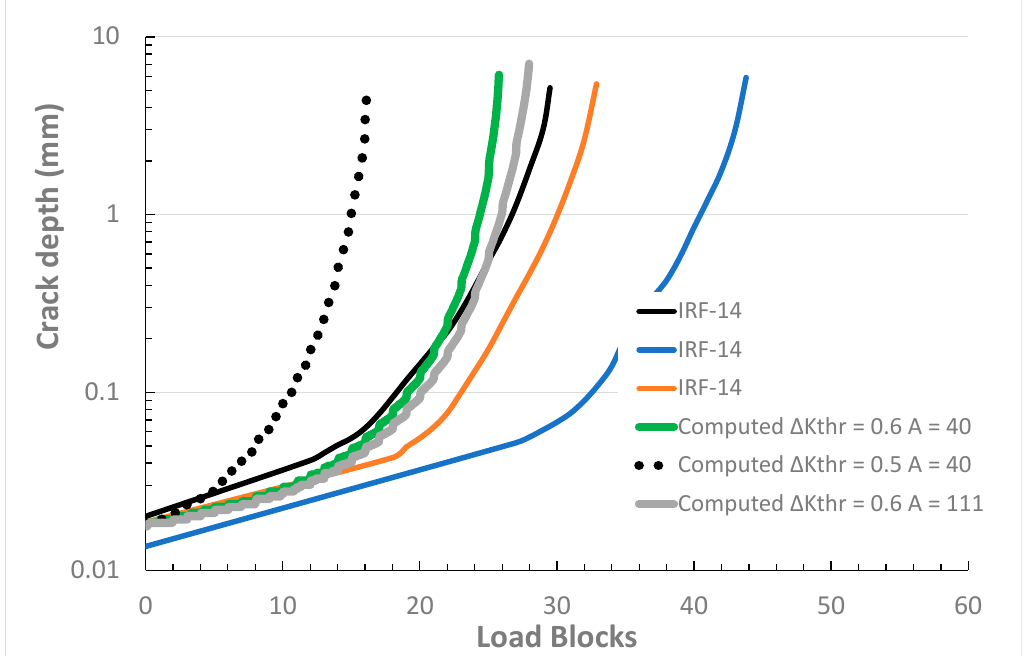
Figure 6. The measured and computed crack depth histories for the helicopter flight load spectrum IRF-E14.